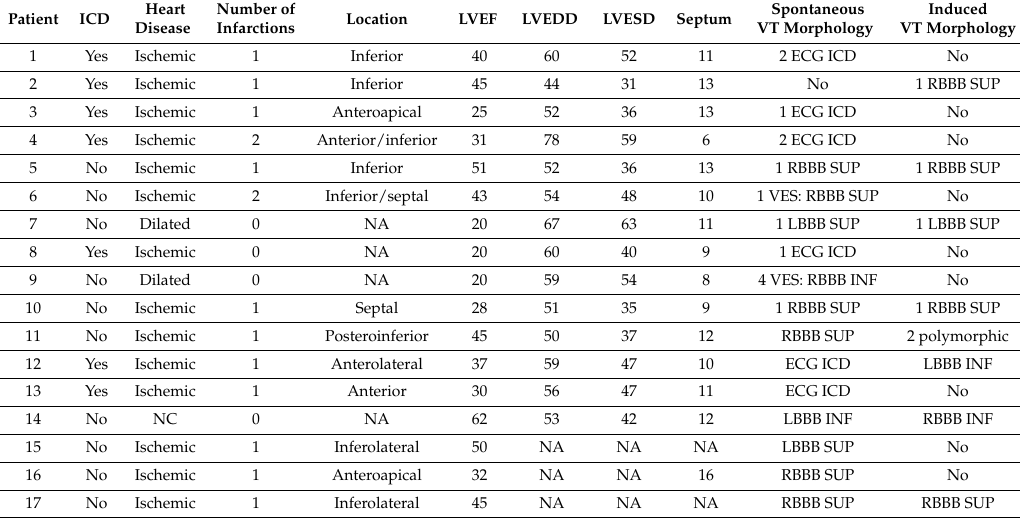
Table 1. Demographic and clinical